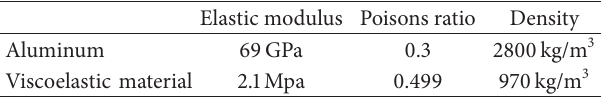
Table 1: Material properties of aluminum and viscoelastic material.